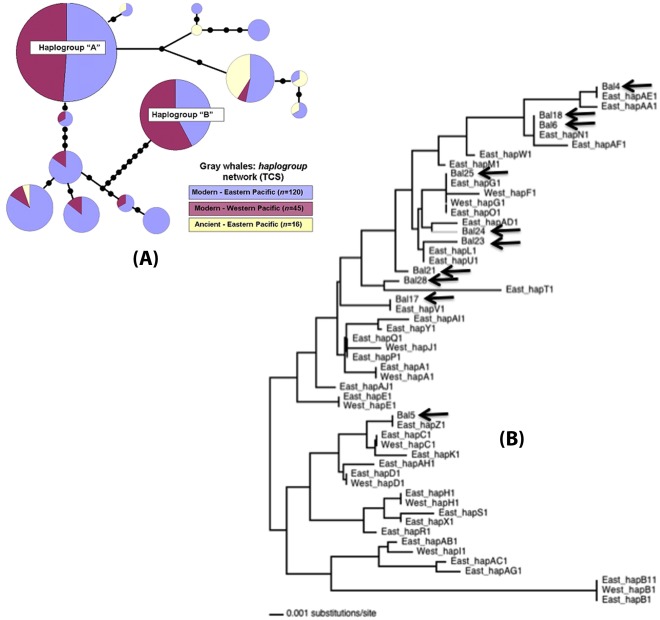
Phylogenetic network and tree constructed from modern and ancient gray whale haplotypes.(a) Haplogroup network for ancient eastern Pacific and modern eastern and western Pacific samples (constructed in TCS [52]). Haplogroups were defined by grouping together sequences with one or zero differences. (b) Neighbor-joining (midpoint-rooted) tree using ancient and modern haplotypes from PAUP* [53]. The HKY85 model [75] was used to correct genetic distances. Ancient samples have the prefix BAL and are denoted with an arrow. Each haplotype is represented only once in the tree.